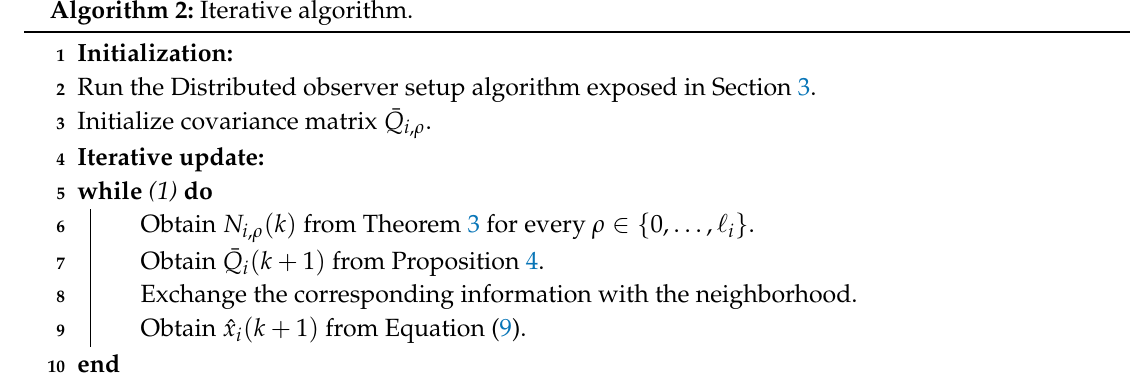
Algorithm 2: Iterative